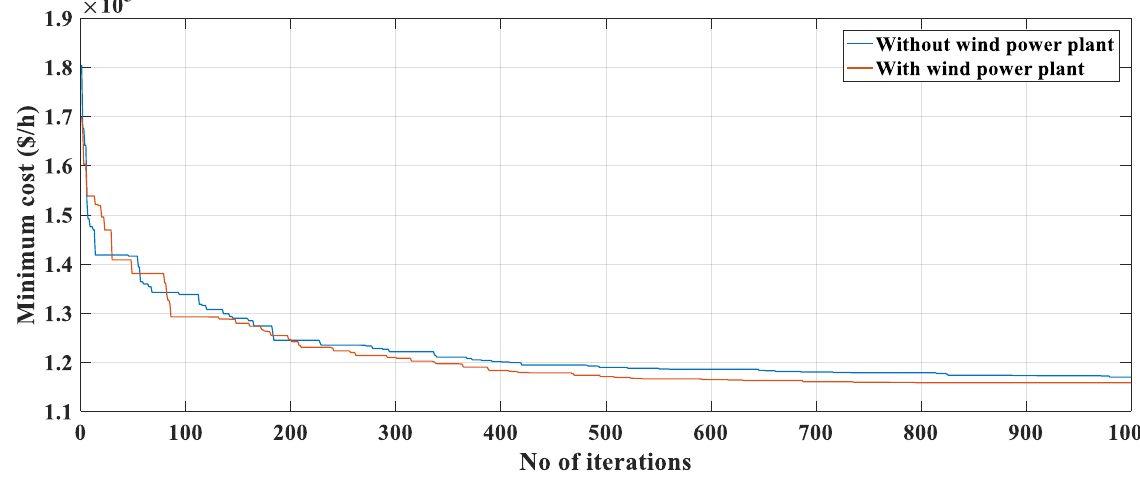
Figure 5. Minimum cost curve considering VPL effect and POZs. Table 3. Optimal allocation of power and heat generation considering VPL effect and POZs.